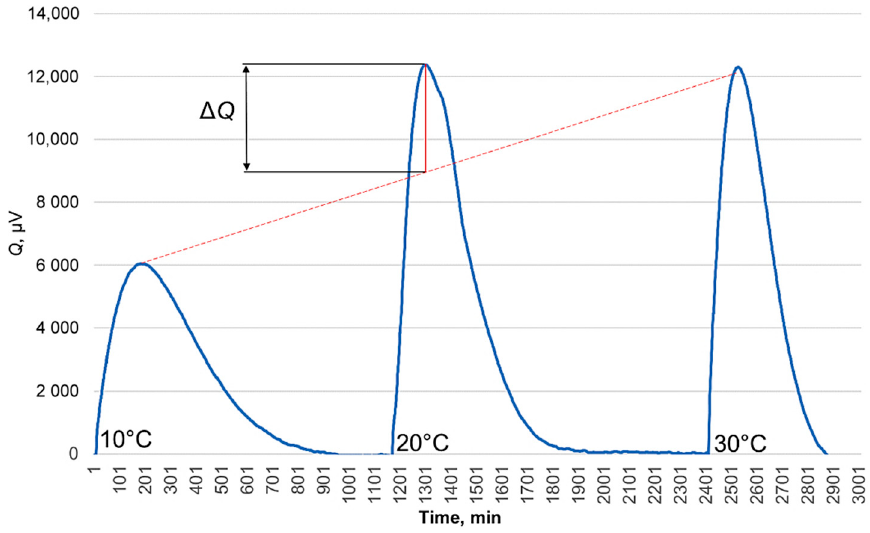
Figure 6. Heat flow meter output during a transient measurement of the specific heat capacity.